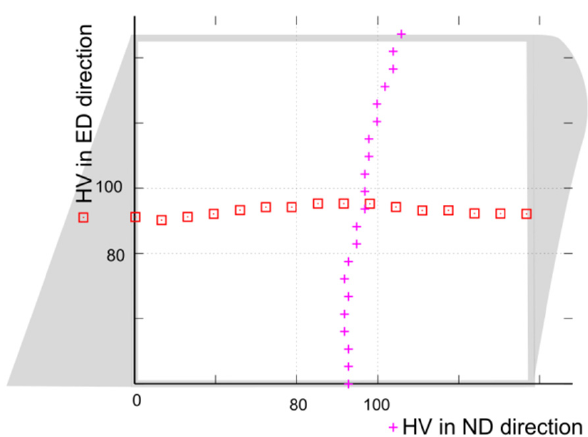
Figure 13. Microhardness profiles in central region of the billet along ED and ND at point 11 (dotted and broken lines in Figure 5).